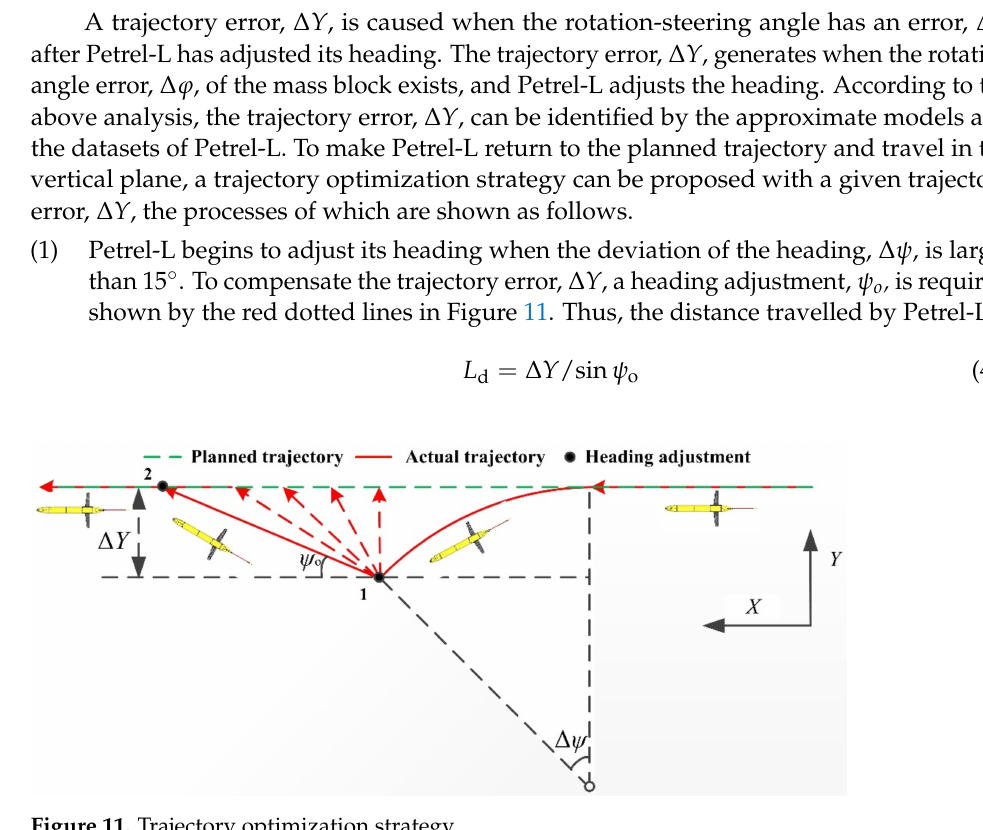
Figure 11. Trajectory optimization